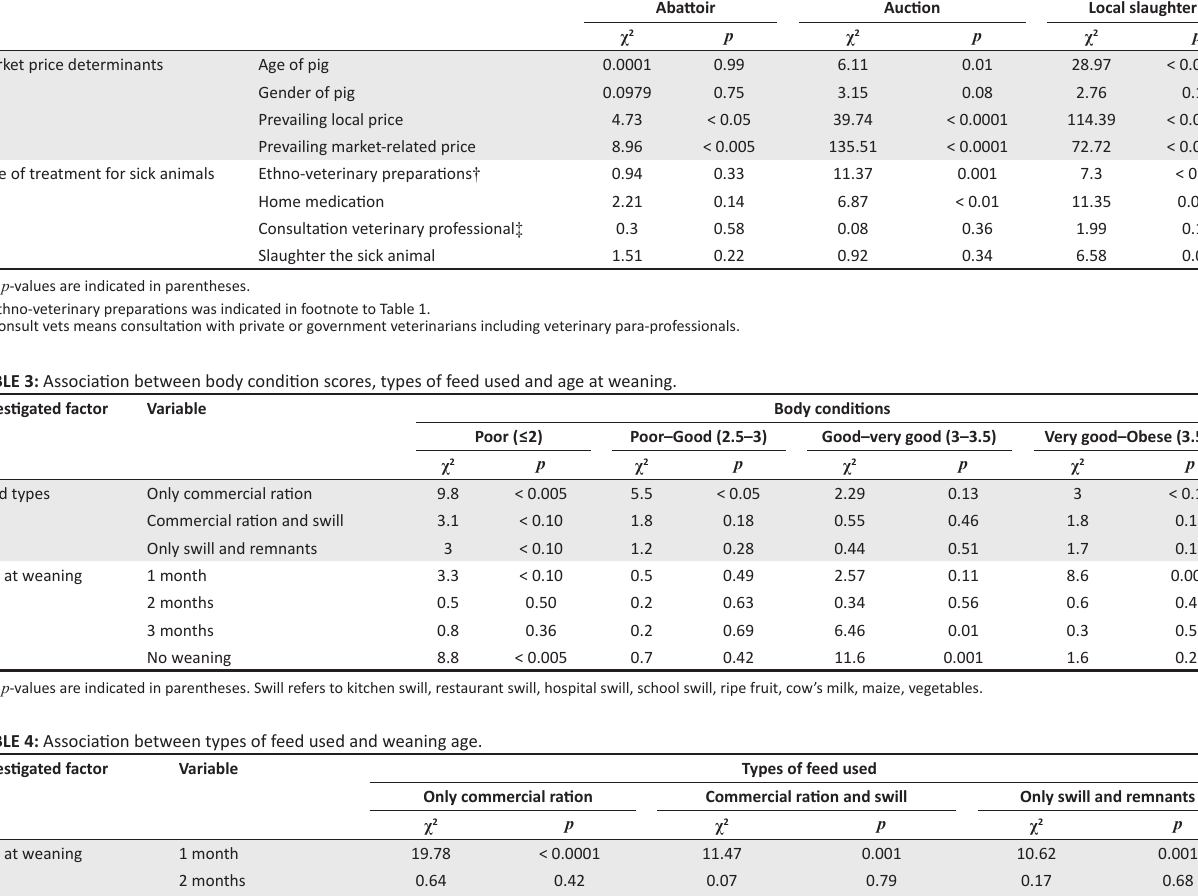
TABLE 2: Association between preferred methods of marketing, market price determinants and type of treatment for sick animals. Investigated factor Variable